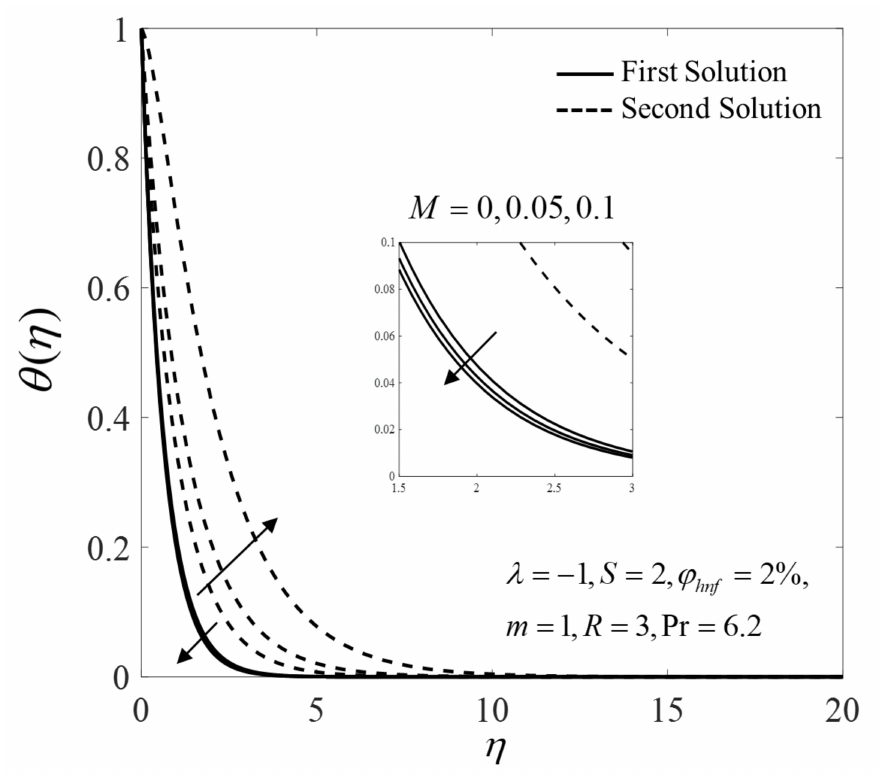
Figure 15. Temperature profiles θ ( η ) for different values of M